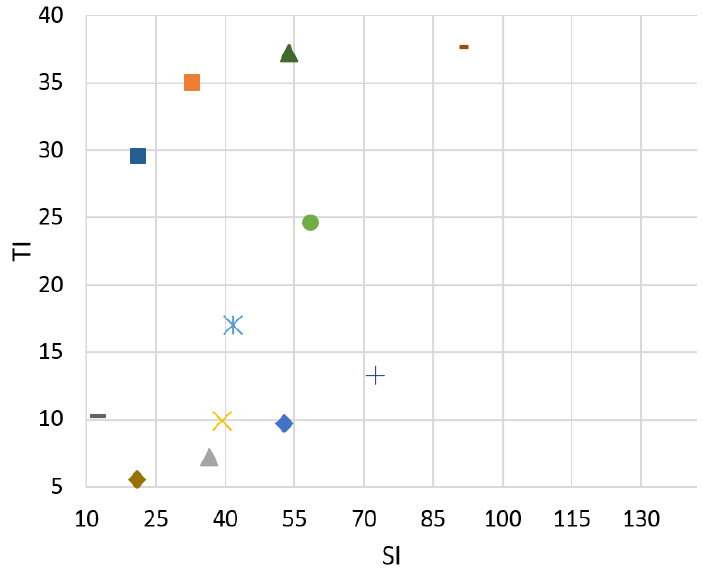
Figure 4. Ultra HD, H.265, bitrate 3